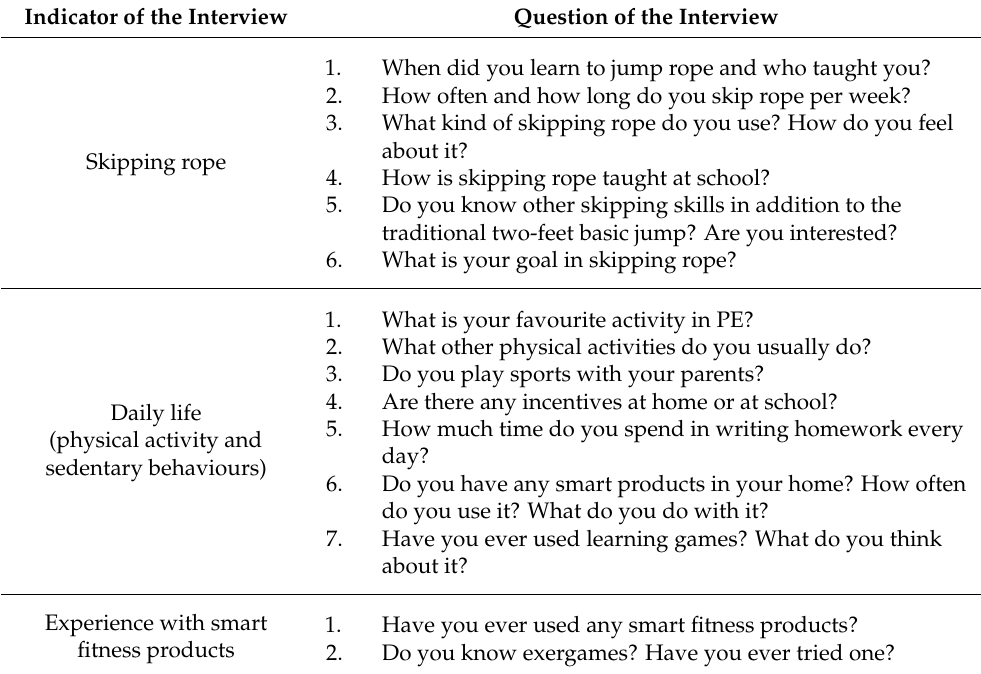
Table 1. List of the questions used in interviews with the pupils. Indicator of the